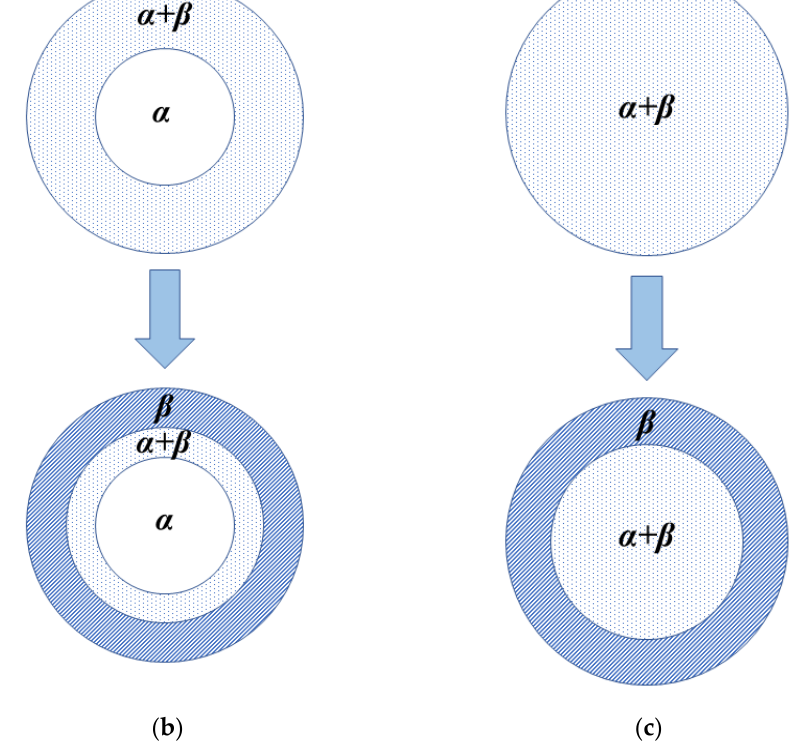
Figure 12. Model of hydriding kinetics. ( a ) model with no two-phase ( α + β ) region (continuous moving boundary); ( b ) model with a definite width of α + β two-phase region; ( c ) model of an entirely two-phase ( α + β ) region in its initial and later stages, respectively [81].